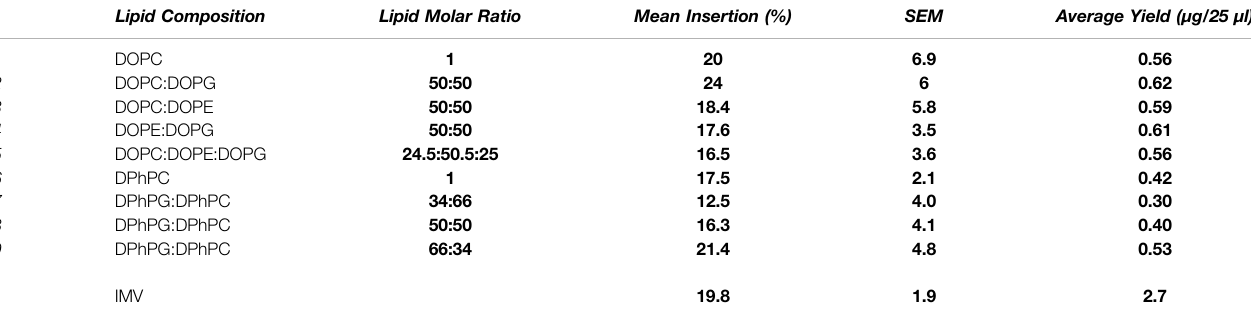
TABLE1| LipidcompositionsandtheirrespectivemolarratiosinvestigatedforLeuTspontaneousinsertion1 – 10.Ineachlipidconditiontheaveragemeaninsertionef fi ciency is provided, calculated as a percentage of protein in the top fraction of the sucrose gradient after puri fi cation. 0% insertion is where proteoliposomes reside solely in the top fraction, and all protein aggregated in the bottom fraction, and 100% insertion where all protein is incorporated into proteoliposomes in the top fraction, and no protein aggregatedinthebottomfraction.AveragetotalyieldsforeachconditionarepresentedasthetotalamountofproteinsynthesizedduringIVTTbeforepuri fi cation.Proteinlost betweenthetotalyieldandtheyieldafterpuri fi cationrangesfrom0 – 0.25 µg,equatingtoanaveragelossof ≤ 25%.Allmeaninsertionef fi cienciesarethuscalculatedfrom thetotalproteinyield.Thetotalproteinyieldsafterpuri fi cationarepresentedin SupplementaryTableS1 .Boththeaverageyieldand meaninsertionef fi ciency(%)were calculatedfromaminimum ofthree repeats( n ≥ 3), andexperimentalerrorsfor meaninsertion arepresented asSEM. Theonlyconditionwhere lessthan